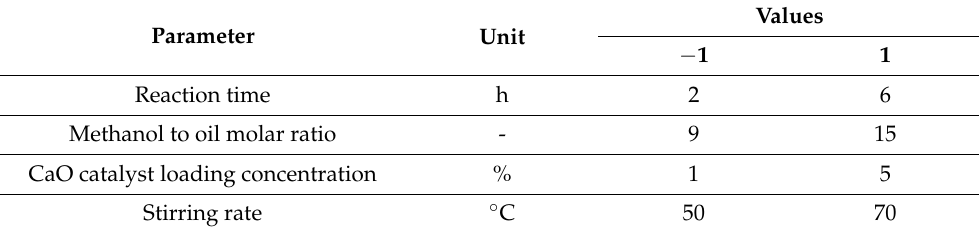
Table 6. Design of experiment matrix for biodiesel production.